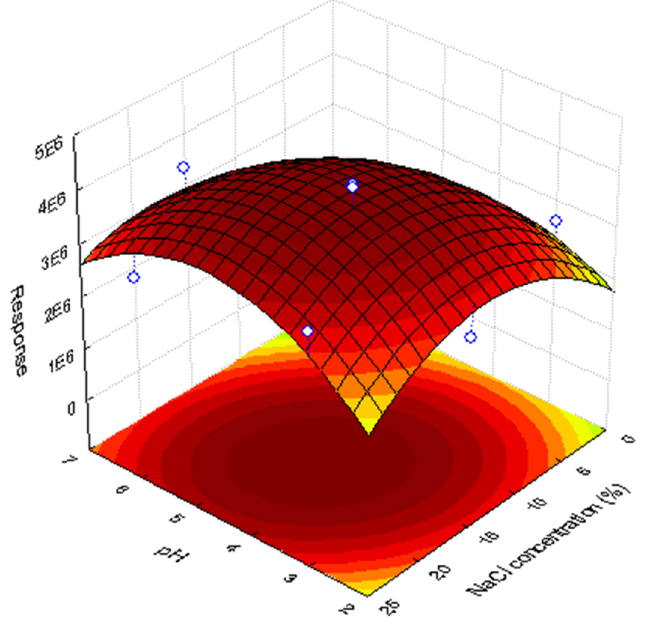
Figure 5. Response surface obtained from Doehlert design for the evaluation of pH and NaCl content (%). Extraction was performed with 20 mg of Si3Py + Cl − ; 100 µ g L − 1 of each analyte; six extraction cycles with 700 µ L of sample in each cycle and 15 s of extraction time; and three desorption cycles with 100 µ L of ACN and 15 s of desorption time.